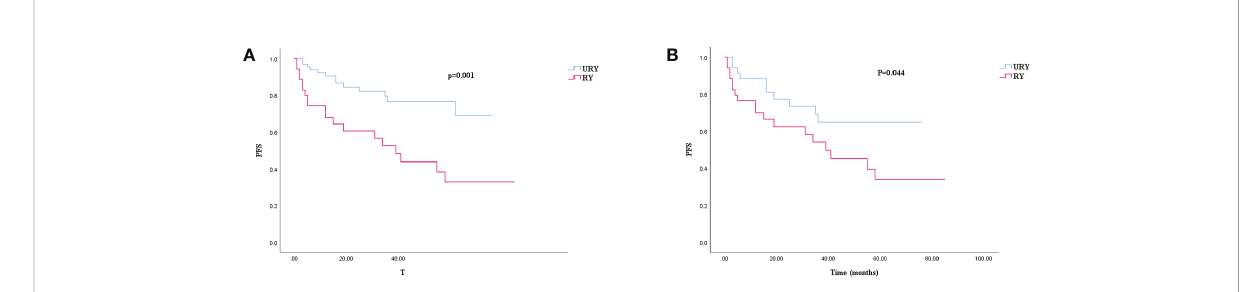
FIGURE 3 Kaplan – Meier survival curve for PFS of URY group and RY group. (A) was unmatched analyses and (B) was propensity-score-matched